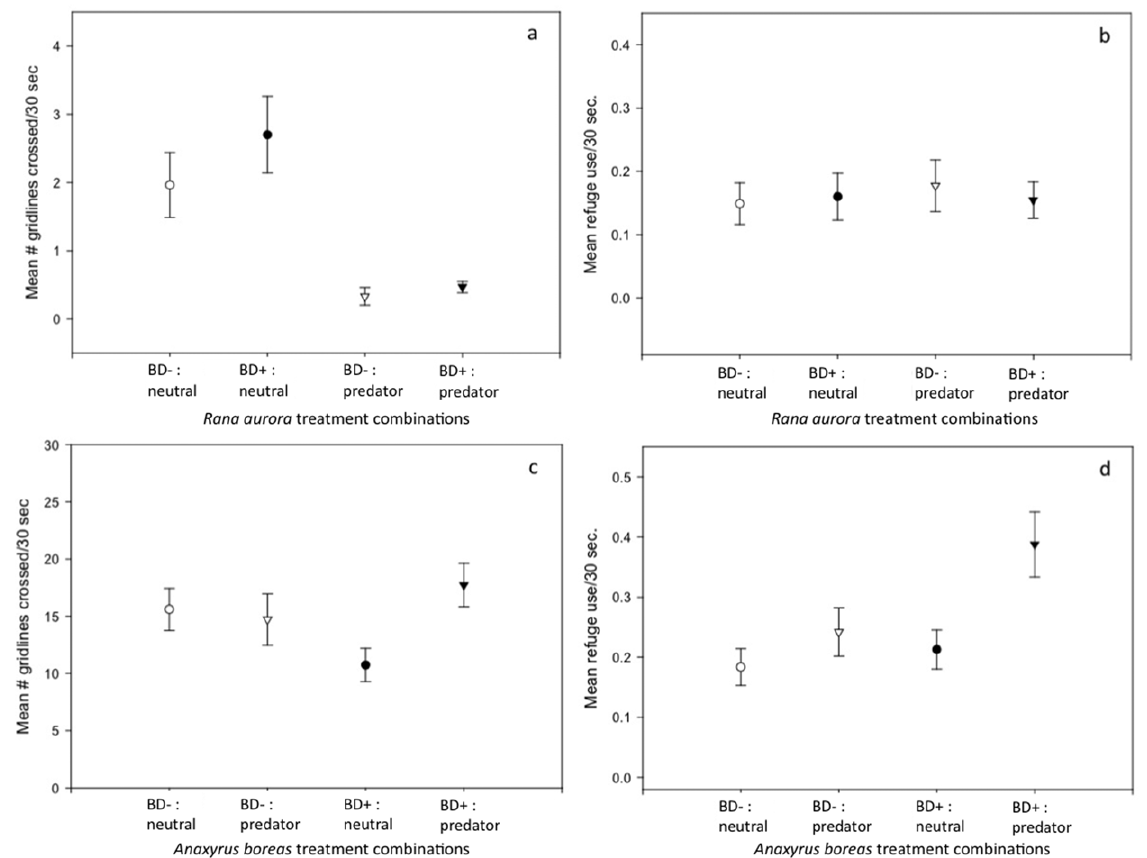
Figure 1. The mean number of gridlines crossed (a) and the mean number of times animals were observed using refuge (b) in 30 seconds for Ranaaurora (a,b) and Anaxyrusboreas (c,d) in a 2 6 2 factorial design with two chemical cue treatments (predator, neutral), and two Bd treatments (Bd + , Bd 2 ). Rana aurora tadpoles decreased activity in the presence of chemical cues from Taricha predators. Bd + Anaxyrus boreas tadpoles were more active and used refuge more frequently when exposed to chemical cues of Ambystoma predators compared to neutral chemical cues.